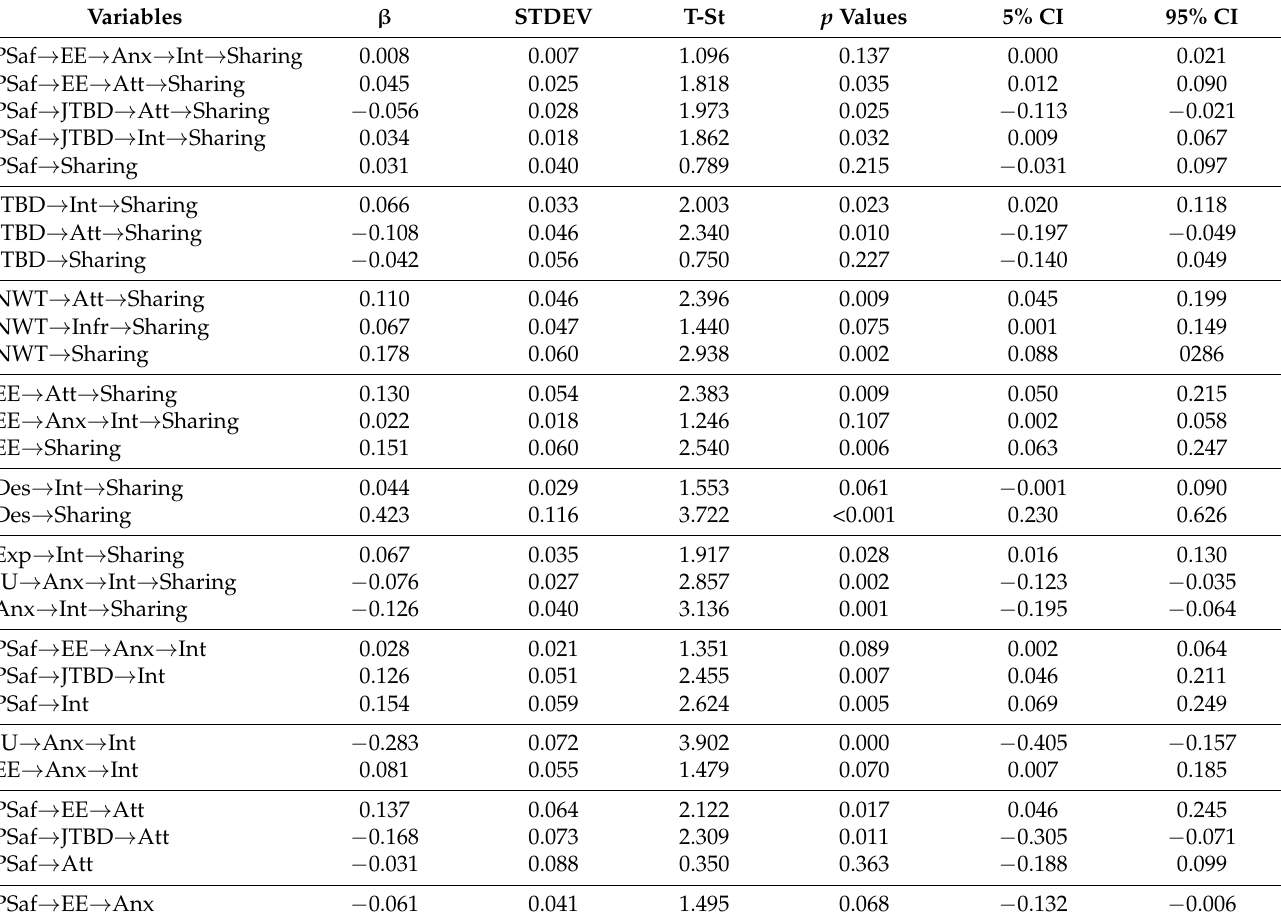
Table A5. Total and specific indirect effects: path coefficients ( β ), standard deviation (STDEV),